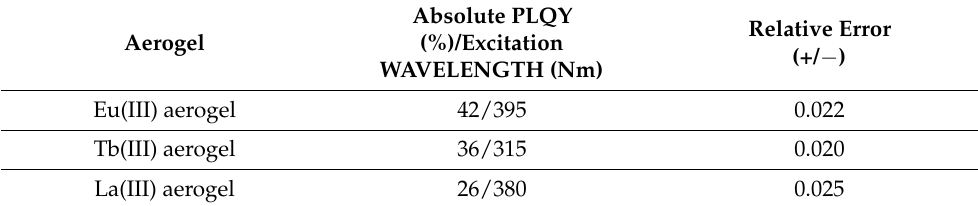
Table 3. Absolute PLQY recorded for the investigated aerogels.